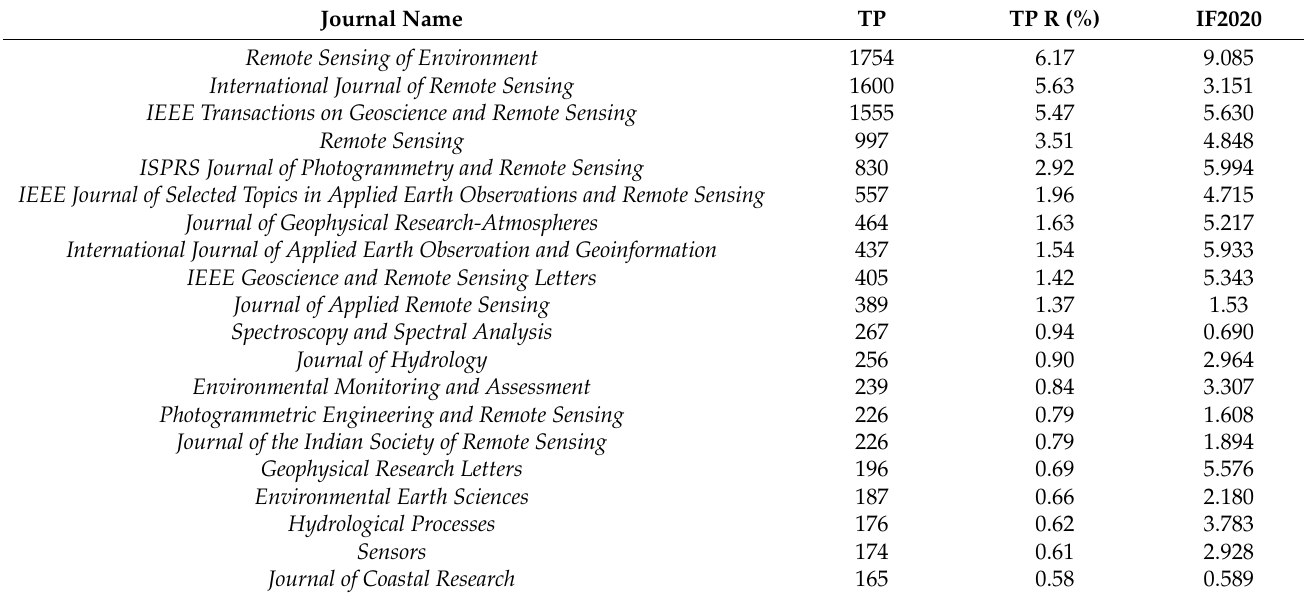
Table 1. The top 20 journals in terms of publication